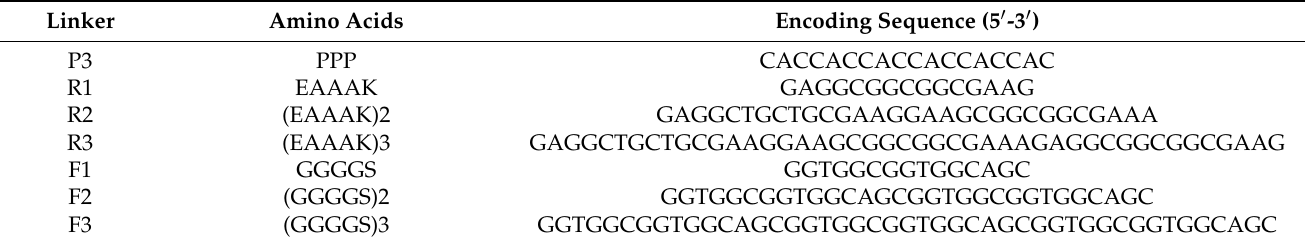
Table 2. Details of the linkers in fusion